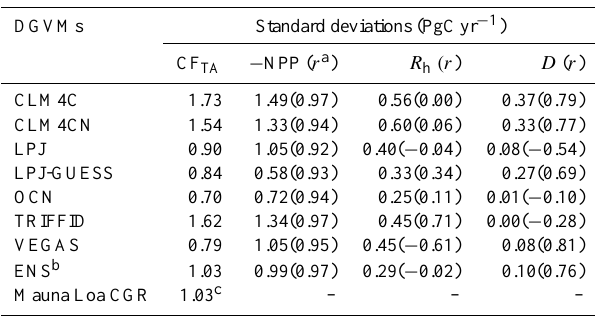
Figure 3. The cross-correlations of anomalies in Mauna Loa CGR with anomalies in the Niño 3.4 index, tropical terrestrial surface air temperature (Tas), precipitation (Pr), soil moisture (SM), and pho- tosynthetically active radiation (PAR). The horizontal axis shows the lead-lag months between them. Negative month values indicate the anomalies in Mauna Loa CGR lag behind. Bold lines indicate correlation above 95% significance ( p ≤ 0 . 05), estimated by the ef- fective degree of freedom. Table 3. Standard deviations of the terrestrial carbon cycle pro-